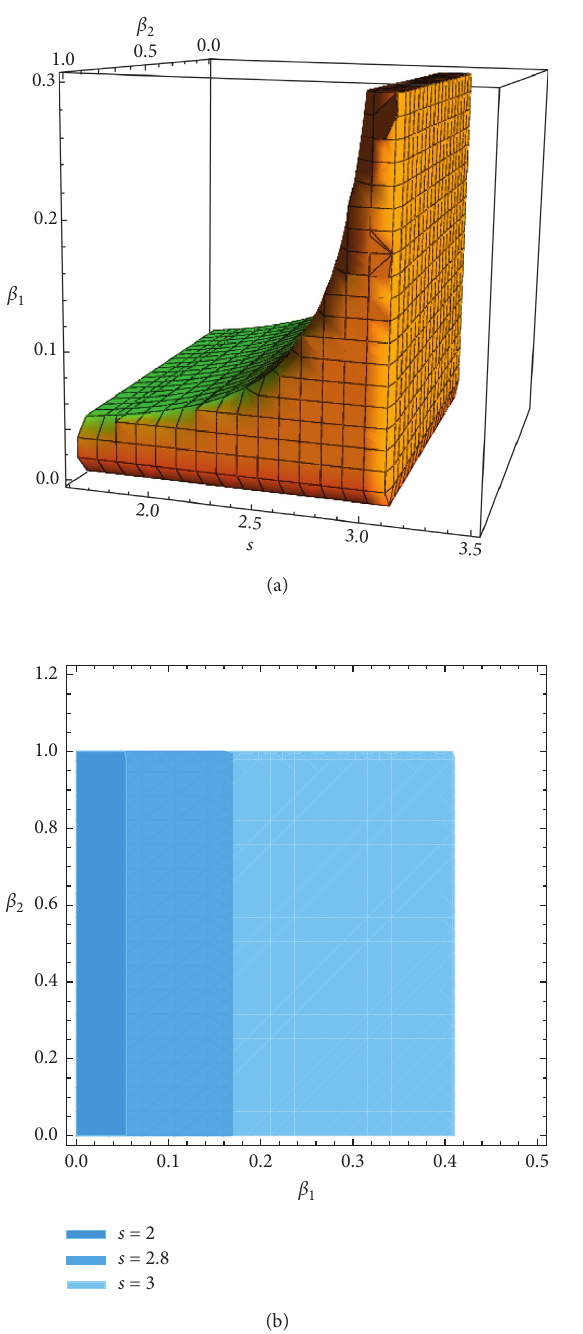
Figure 28: Stable region with respect to β region. (b) 2D stable region in the ( β